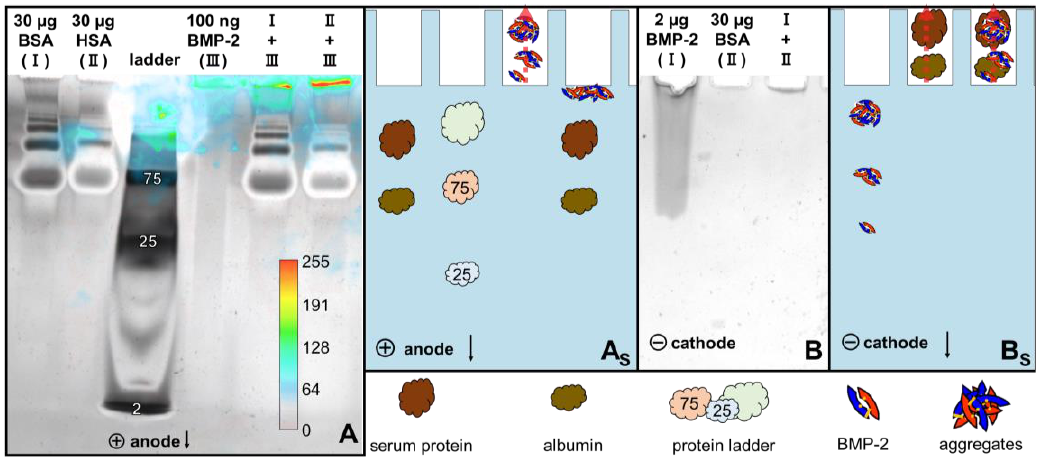
Figure 6. ( A ) Silver staining and overlay of luminescence intensity after Western blot of identical gel, after anodic native PAGE at pH 8.3, ( A S ): explanatory illustration of A , ( B ) silver staining after cathodic native PAGE at pH 7.6, ( B S ): explanatory illustration of B . Red arrows illustrate the apparent direction of movement.